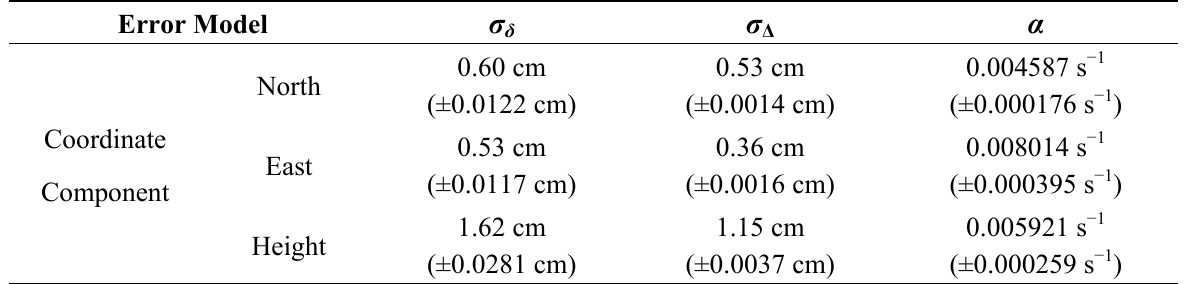
Table 4. Error model applied to the NRTK application positioning